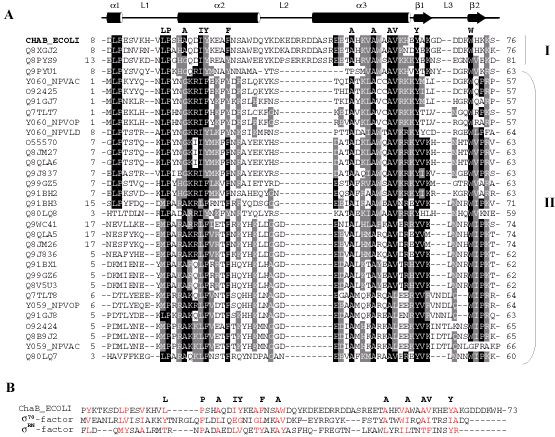
Sequence alignment of the family of ChaB proteins. (A) Alignment of ChaB from E. coli aligned with a series of related proteins identified by Pfam [34]. In bold above alignments, are residues most conserved among ChaB proteins. Cartoon diagram above represents the secondary structure of ChaB. ChaB from E. coli (in bold) Salmonella typhi (Q8XGJ2)and Methanosarcina mazei (Q8PYS9) are classified as group I ChaB proteins. Group II ChaB proteins are all found in Baculoviridae. The figure was created using BOXSHADE (EMBnet). Identical amino acids are highlighted in black and homologous residues in gray. (B) Sequence alignments of ChaB and related proteins σ70 and σRN based structural composition (see text for details).